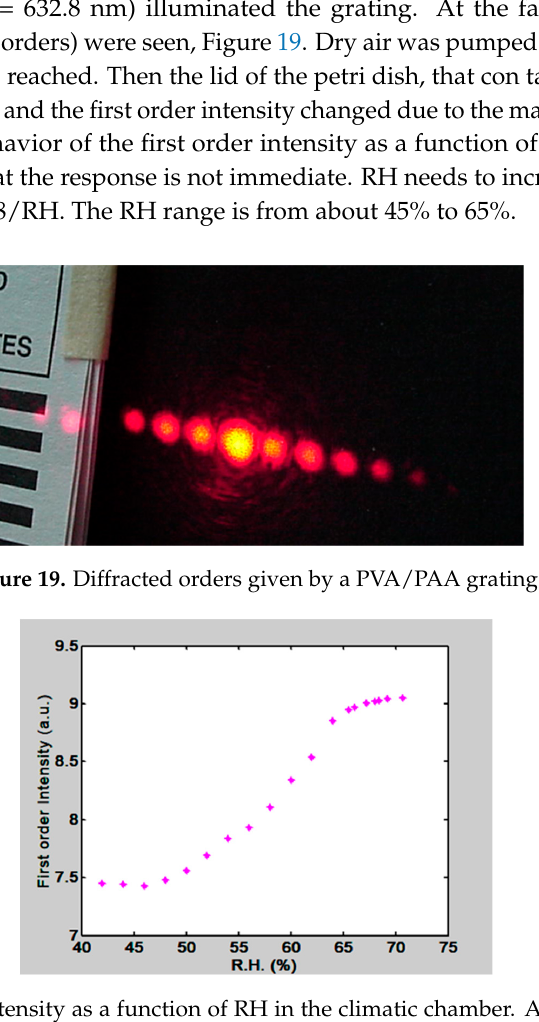
Figure 21. Normalized First order intensity, as a function of RH, for two gratings recorded in 15 µm and 50 µm thickness gelatin layers. We should mention that when RH reached a value of about more than 70% the films became loose, Figure 22. At this stage the orders light intensity values should not be considered because it is possible that light illuminates another part of the grating that could have another profile.